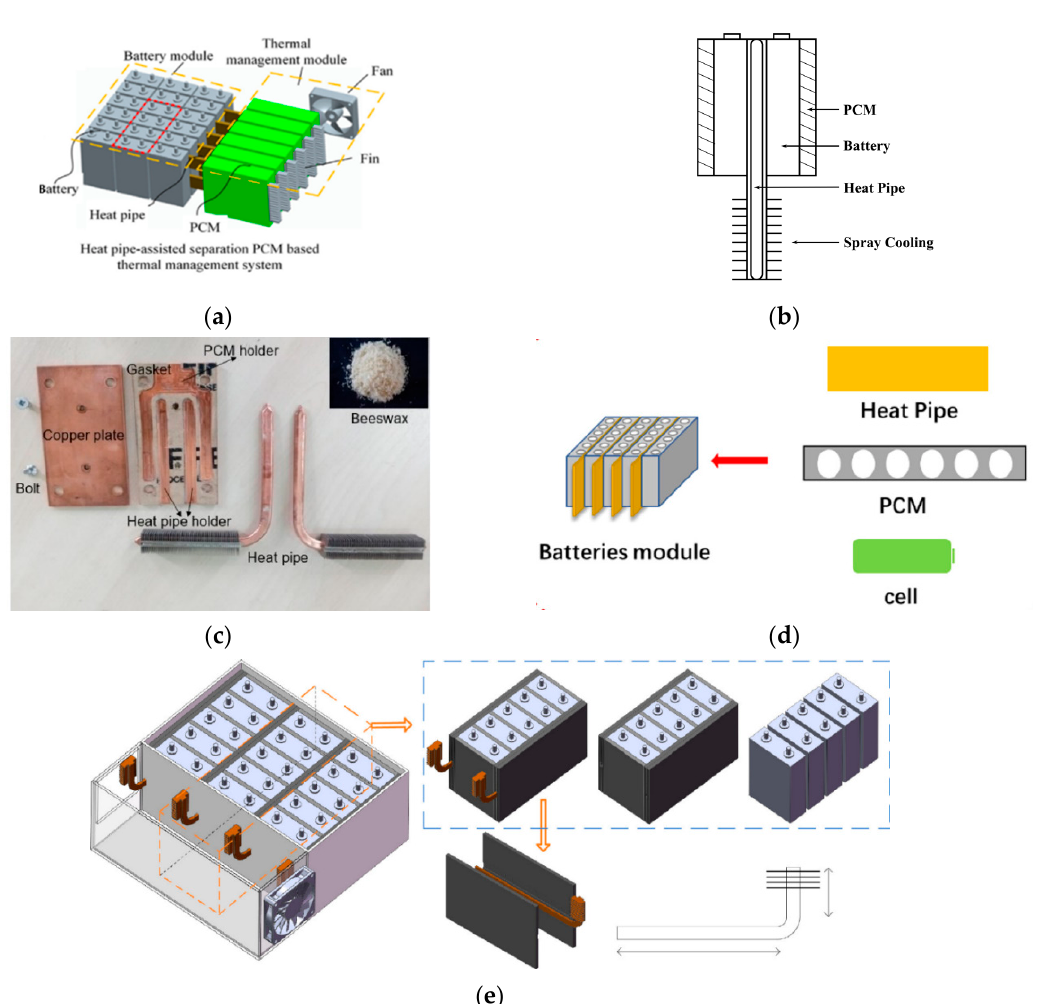
Figure 8. Classic examples of hybrid BTMS associated with PCM and HP ( a ) HP-assisted PCM based